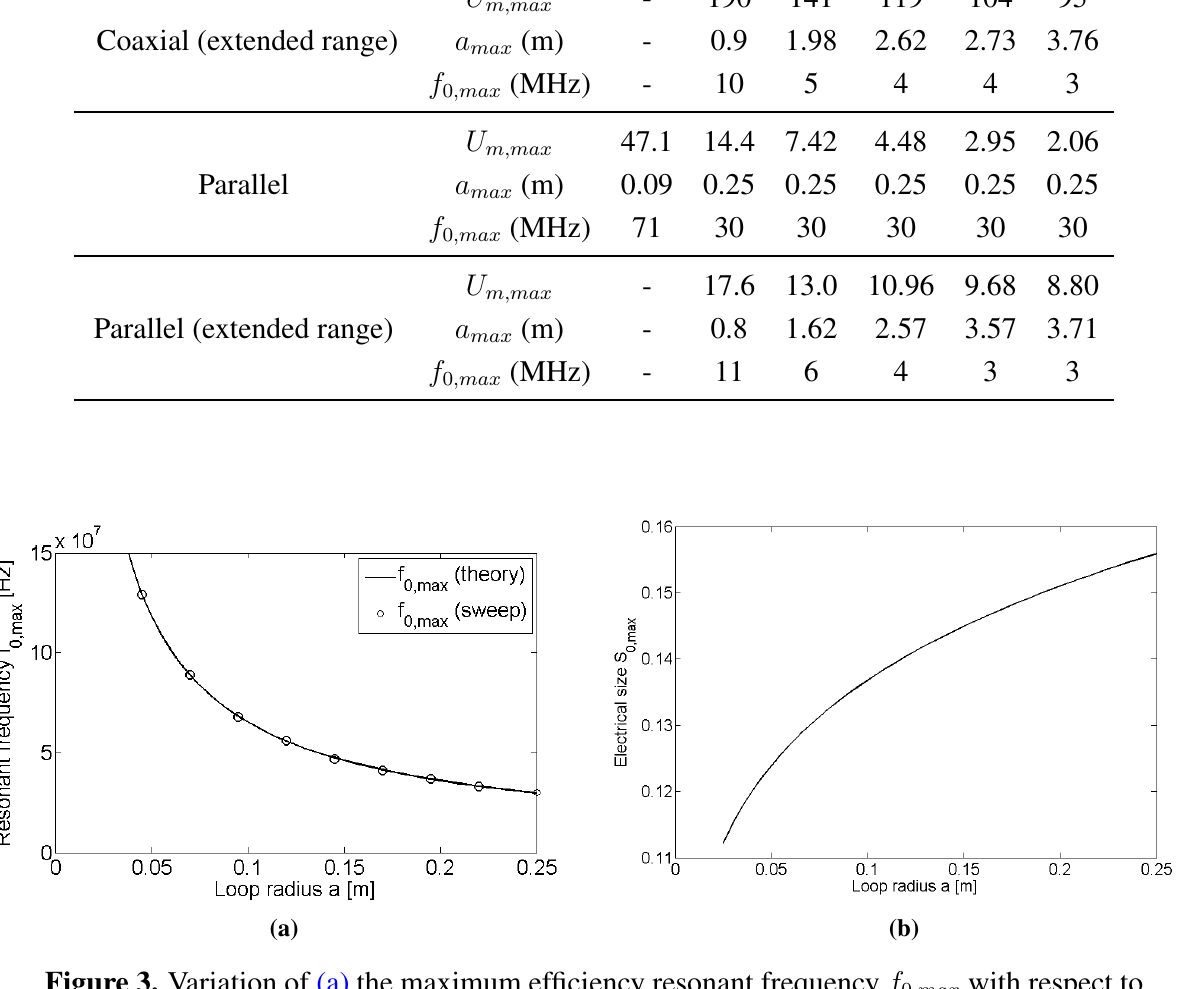
Figure 3. Variation of (a) the maximum efficiency resonant frequency f the loop radius a and (b) the variation in the electrical size of the loop S at f with respect to loop radius a 0 ,max